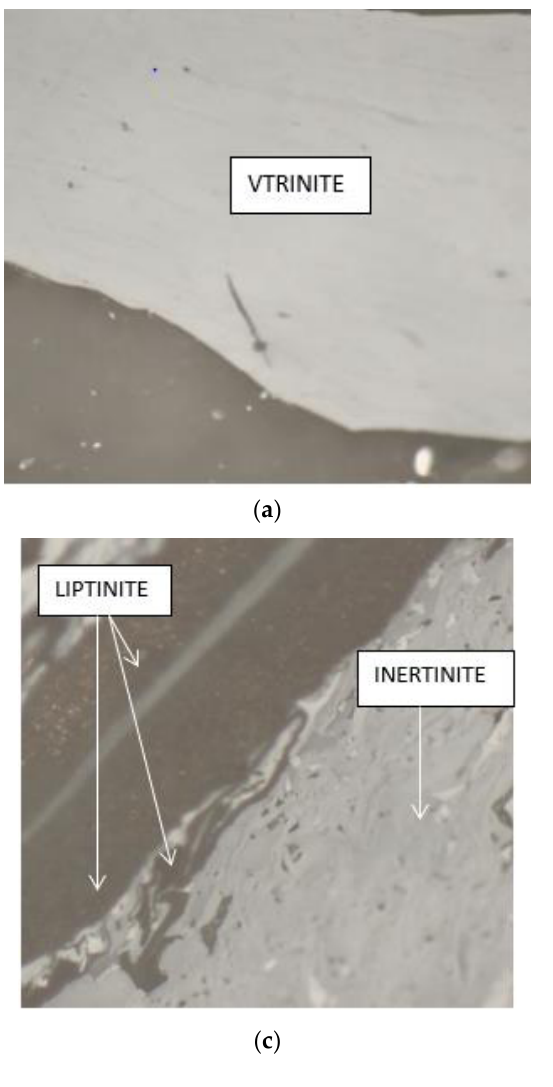
Figure 1. Maceral groups: ( a ) vitrinite; ( b ) liptinite and inertinite; ( c ) liptinite; ( d ) inertinite and vitrinite. Oil immersion, magnification 500 ×